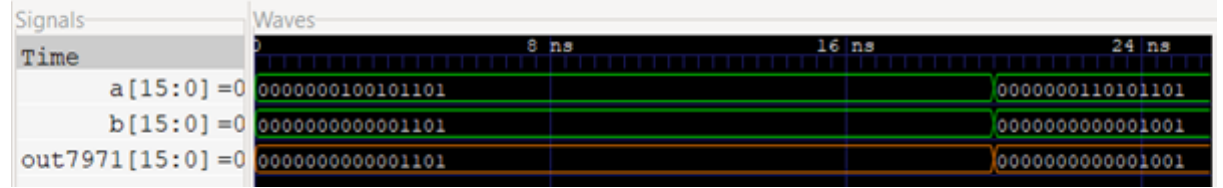
Figure 15. Waveform results of the bitwise AND